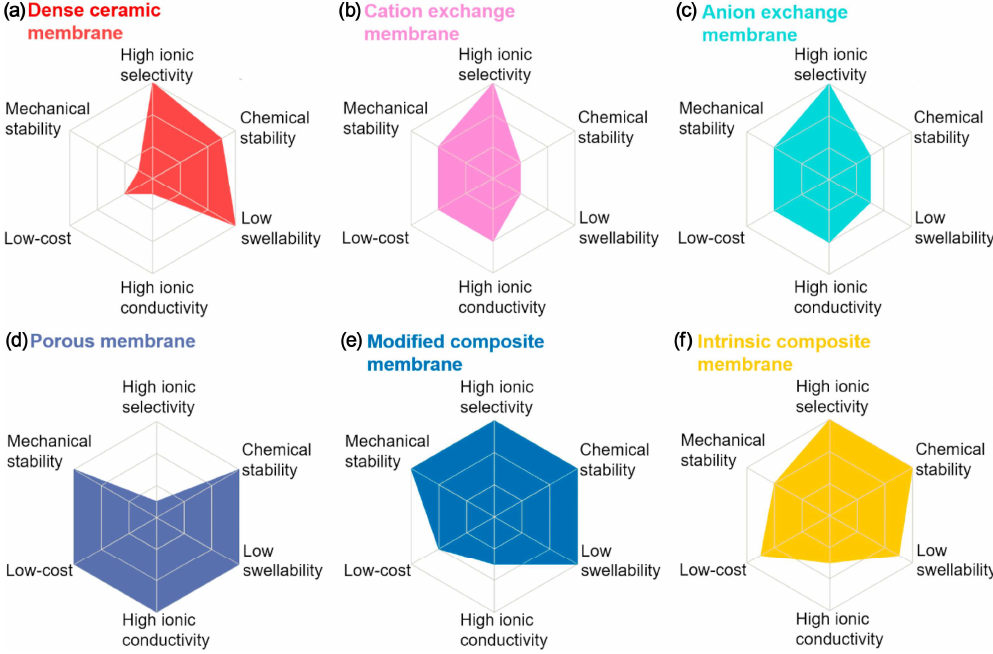
Figure 7. Radar plots of the performance properties of different membranes [63]. Copyright 2021, Elsevier.